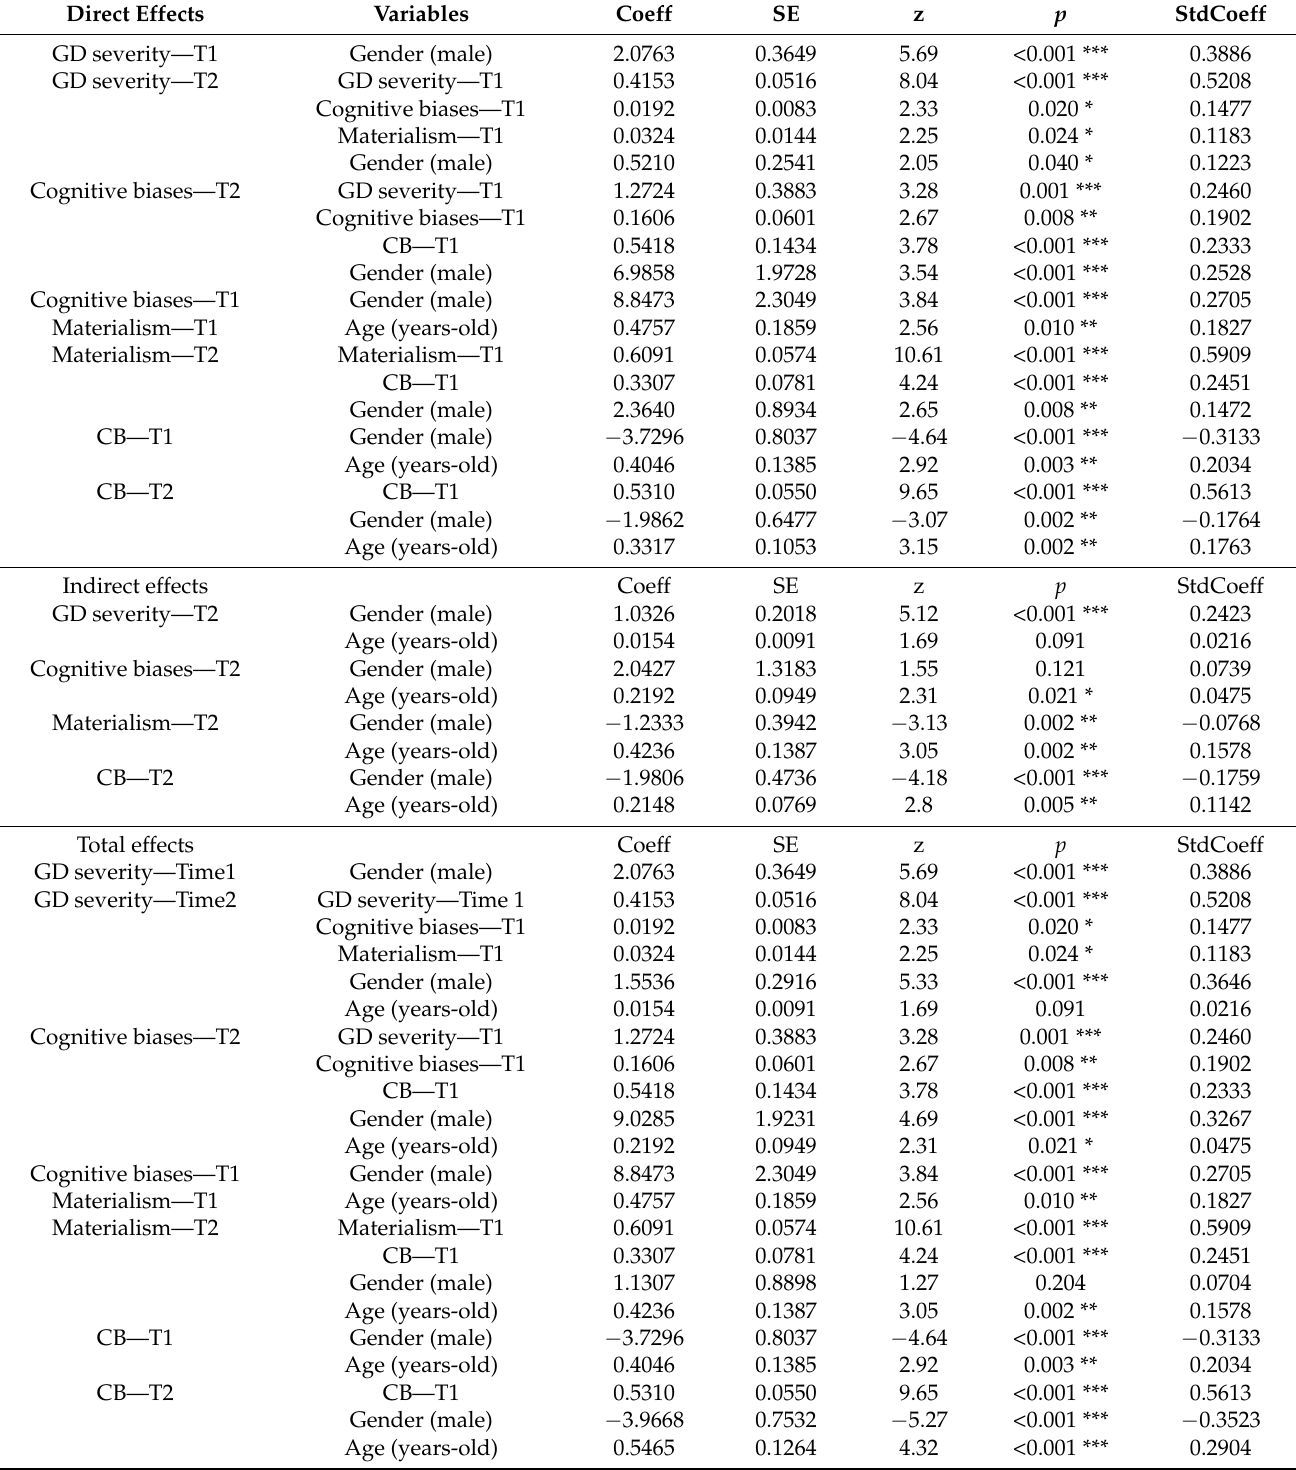
Table 3. Path analysis: direct, indirect, and total